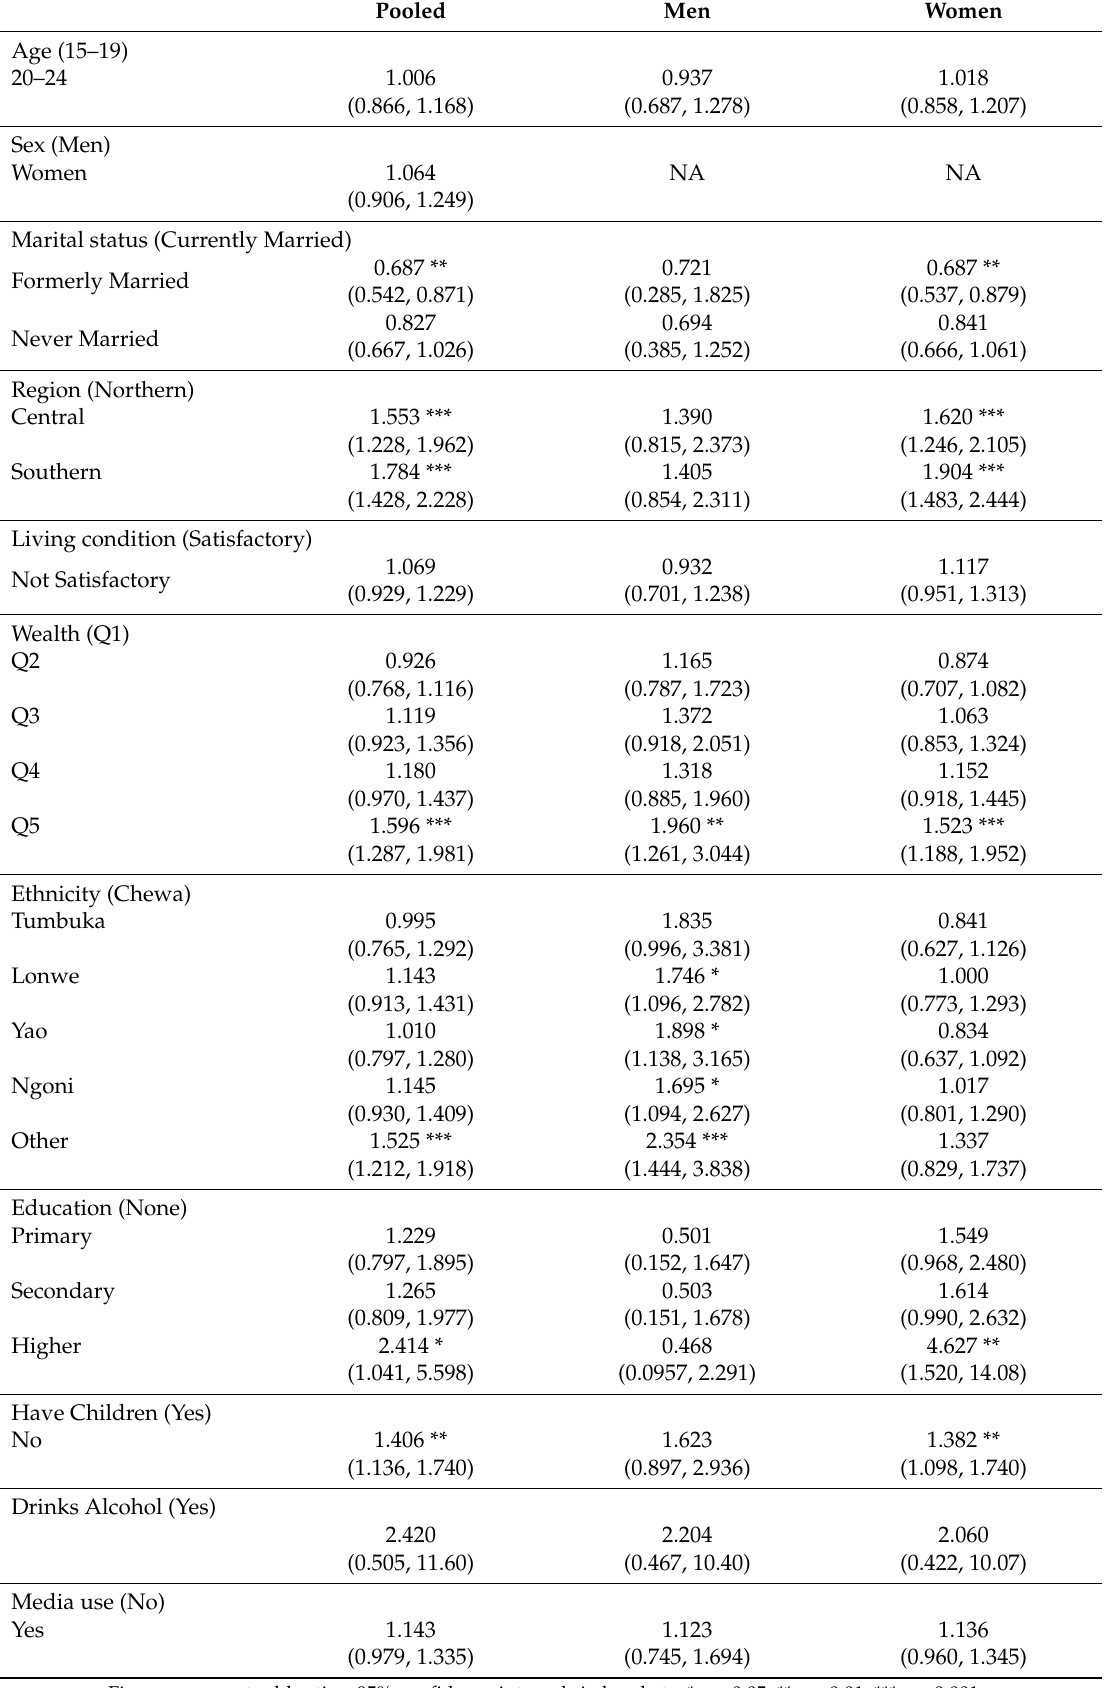
Table 3. Predictors of perceived health satisfaction among men and women. Malawi MICS 2013–2014. Pooled Men